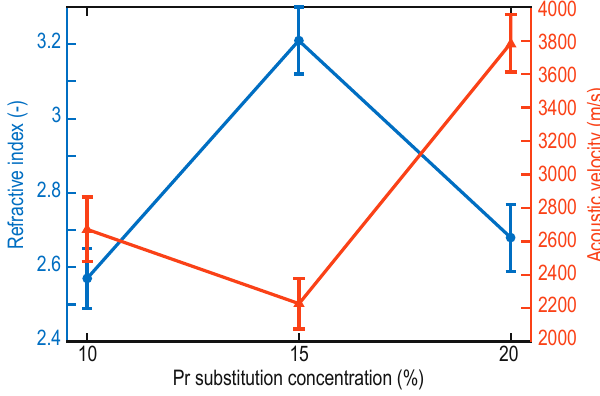
Figure 6. Dependencies of the optical refractive index and of the longitudinal sound velocity on the